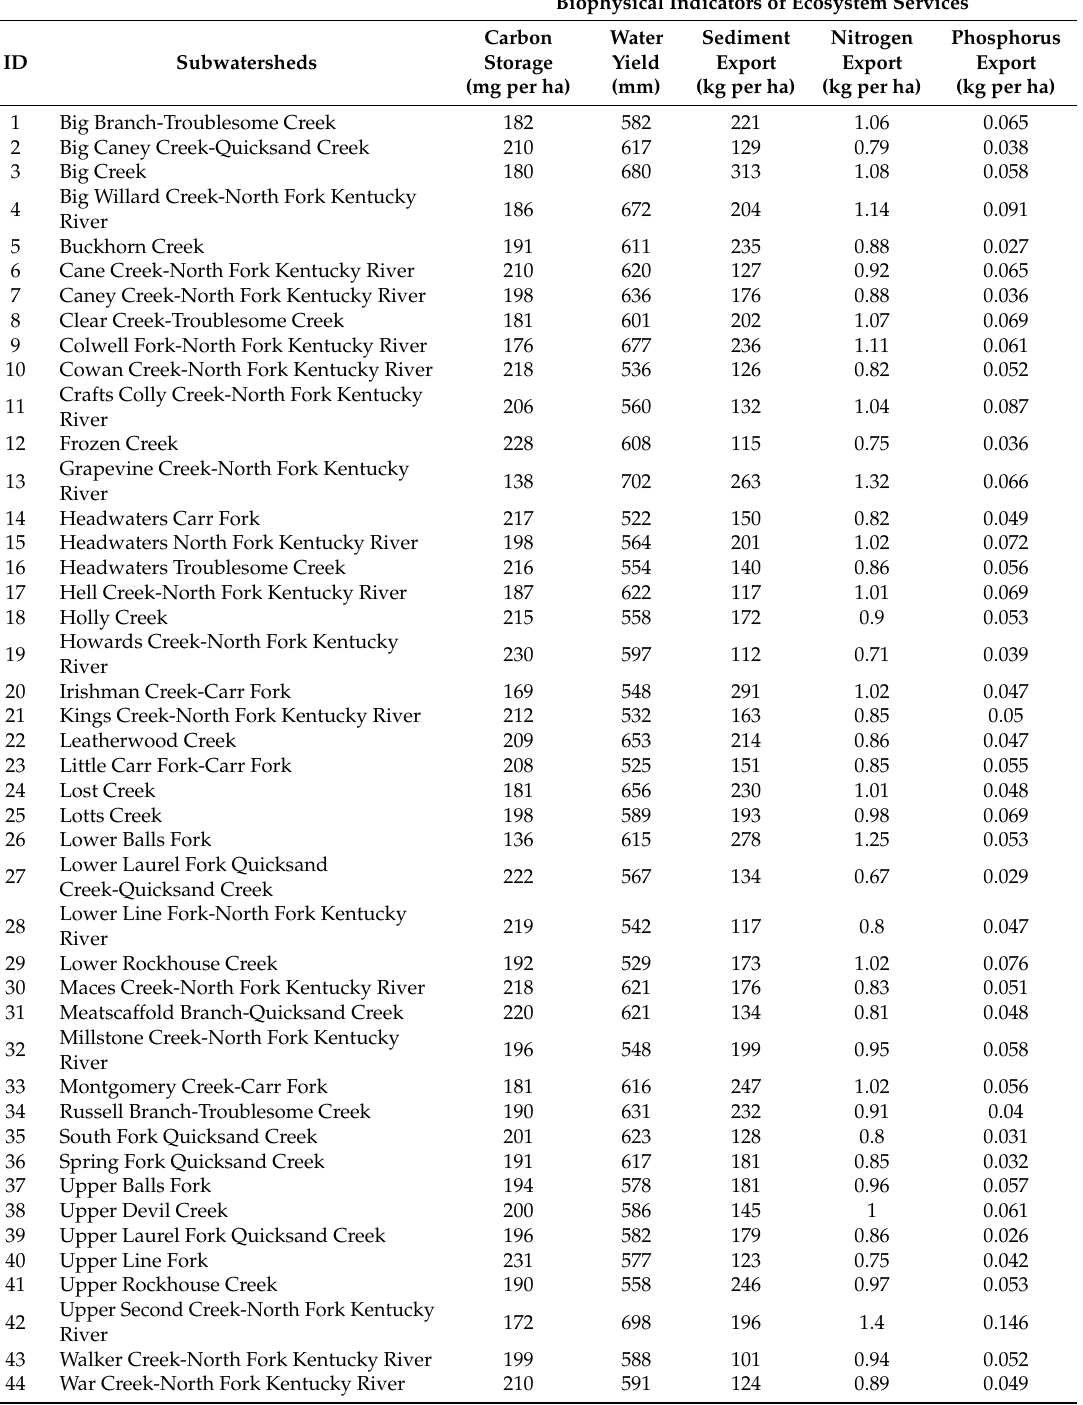
Table A5. Mean ecosystem service production per subwatershed under 2011 LULC conditions. Biophysical Indicators of Ecosystem